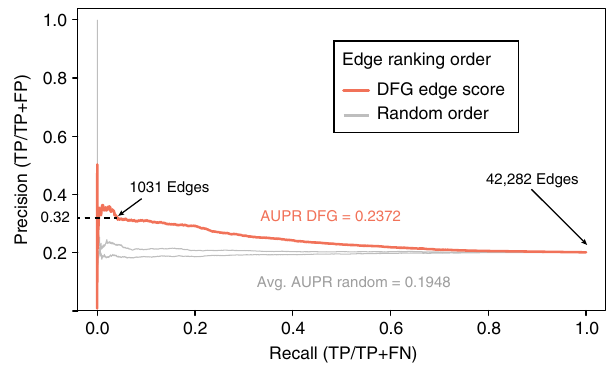
Fig. 6 Validation of a time-inferred network using area under precision recall analysis. Genome-wide regulated targets of 29 transcription factors (TFs) captured in root cells using the TARGET (Transient Assay Reporting Genome-wide Effects of Transcription factors) system (Fig. 2, Supplementary Data 2) were used to calculate the precision and recall of the dynamic factor graph (DFG) inferred gene regulatory network (GRN) based on N×Time response genes in roots. Area under precision recall (AUPR) analysis demonstrates that the ranking of edges in the DFG time-inferred network (orange line) is signi fi cantly better ( p value < 0.001, permutation test) than randomizing the order of edge rankings ( n = 1000) (gray lines represent random networks with highest and lowest AUPR). From this plot a 0.32 precision cut-off was chosen as the highest value before the curve fl attens.